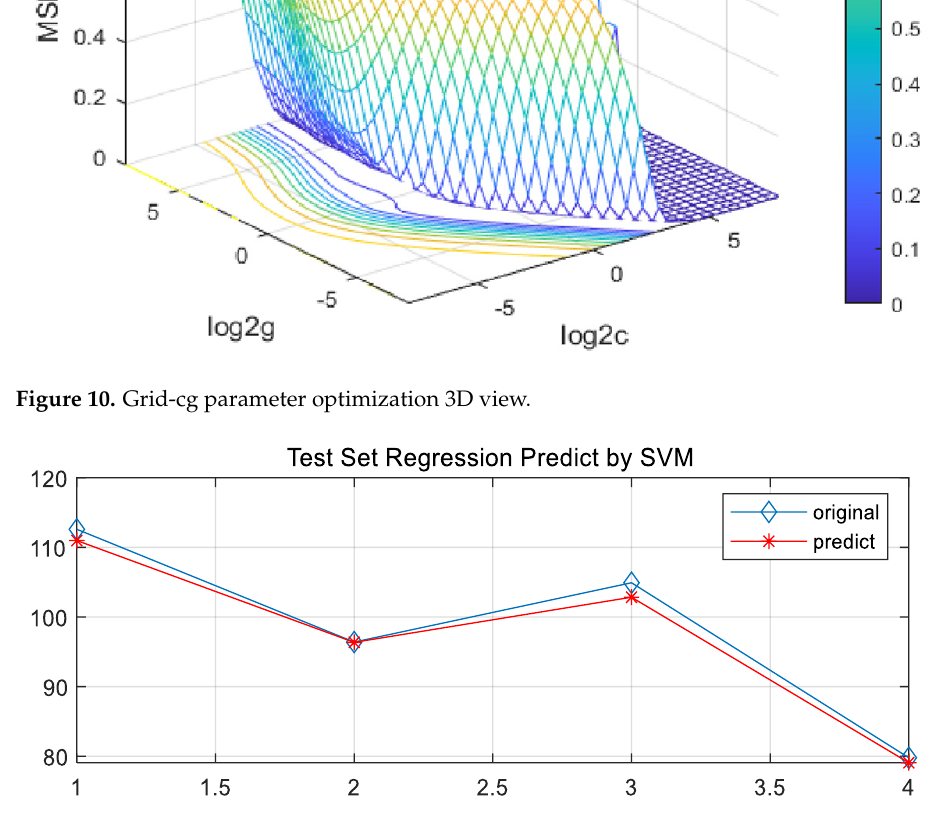
Figure 11. Grid-SVM test set data fit.